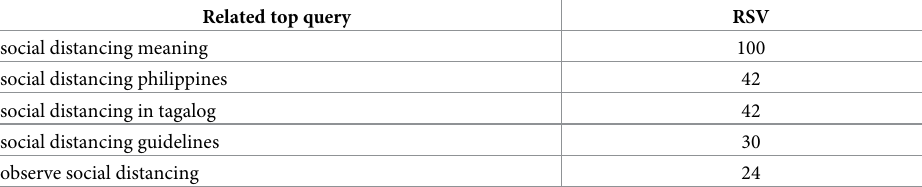
Table 4. Related top queries and search interest value for “social distancing”.